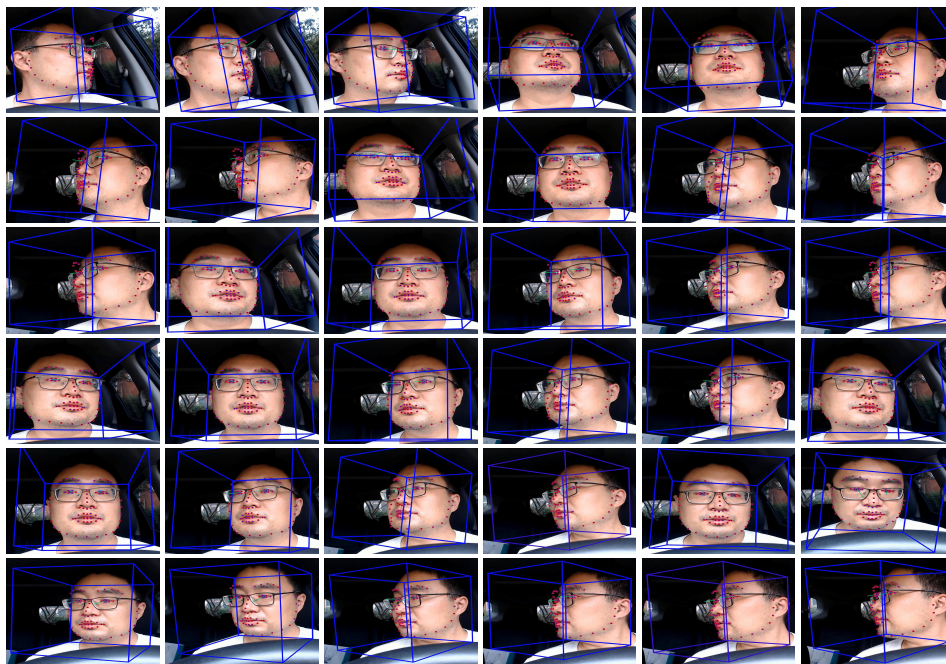
Figure 4. The driver status extraction results of all the partitioned gaze zone. The first row shows the results of GZ1 ∼ GZ6. The second row shows the results of GZ7 ∼ GZ12. The third row shows the results of GZ13 ∼ GZ18. The fourth row shows the results of GZ19 ∼ GZ24. The fifth row shows the results of GZ25 ∼ GZ30. The last row shows the results of GZ31 ∼ GZ36. GZ: Gaze